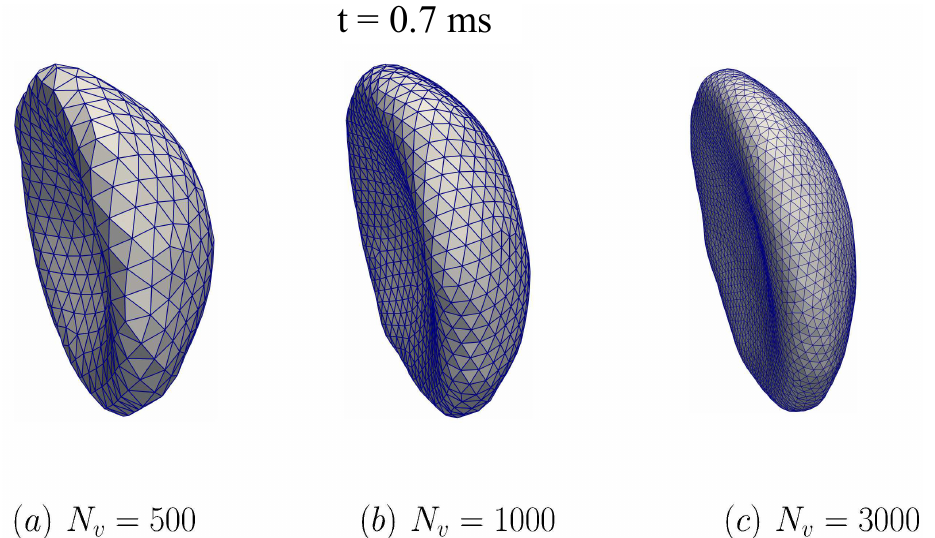
Figure 11. The impact of DPD particles N v on the membrane dynamics during the fluid-structure interaction simulation. Three values of N v are examined: ( a ) N v = 500, ( b ) N v = 1000, and ( c ) N v = 3000. The computational setup is shown and discussed in Figure 9, the fluid do- main is chosen as Grid-1 (see also Table 2). In all cases, the simulated RBC is compared across different N v at the time instant t = 0.7 ms. The RBC is transitioning to the parachute shape. The RBC shape is nearly identical between N v = 1000 and N v = 3000